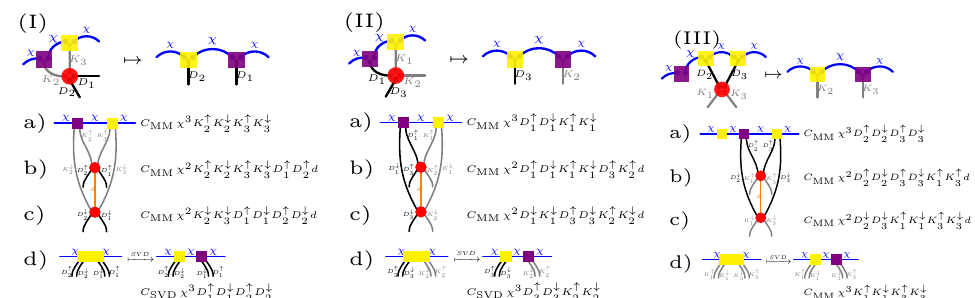
Figure 7: Illustration of the three contraction steps involved in the approximate con- traction of a PEPS on the kagome lattice. (I) Details on step (I): The first row de- picts the overall contraction step. (a)-(d) show the contractions performed in each sub-step and their corresponding computational cost. The superscript (cid:108) indicates, whether a given index corresponds to the upper or lower level of the PEPS network. As in the case of the square two-dimensional lattice, lines terminating in a tensor for a given step are contracted, whereas non-terminated lines correspond to free indices of the tensors. (II) Details on step (II): The first row depicts the overall con- traction step. (a)-(d) show the contractions performed in each sub-step and their corresponding computational cost. The superscript (cid:108) indicates, whether a given in- dex corresponds to the upper or lower level of the PEPS network. As in the case of the square two-dimensional lattice, lines terminating in a tensor for a given step are con- tracted, whereas non-terminated lines correspond to free indices of the tensors. (III) Details on step (III): The first row depicts the overall contraction step. (a)-(d) show the contractions performed in each sub-step and their corresponding computational cost. The superscript (cid:108) indicates, whether a given index corresponds to the upper or lower level of the PEPS network. As in the case of the square two-dimensional lattice, lines terminating in a tensor for a given step are contracted, whereas non-terminated lines correspond to free indices of the